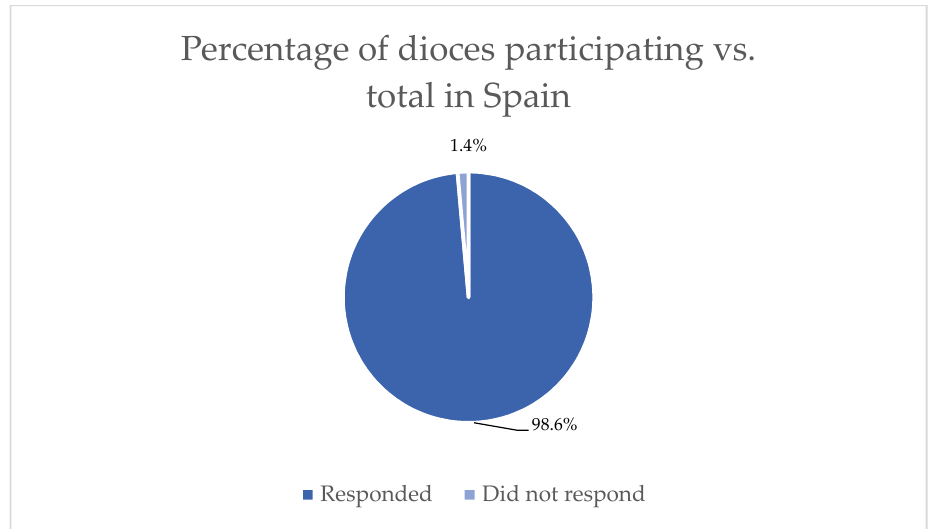
Figure 1. Percentage of participating dioceses vs. the total in Spain. Source: Authors.